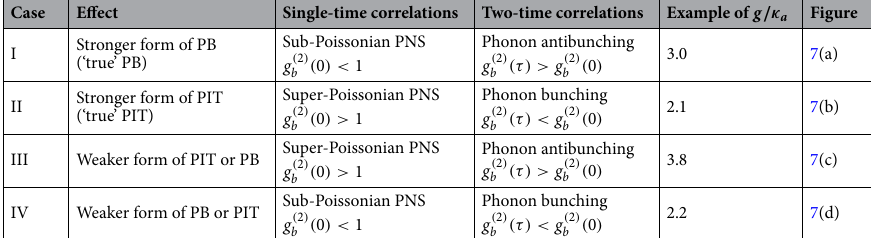
Table 2. Different single- and two-time phonon-number correlation effects induced in the QD mode, which can be observed for different values of the qubit-SMR coupling strength g with respect to the SMR decay rate κ a , e.g., by setting the other parameters to be the same as in Eq. (30). Here, PNS stands specifically for the phonon-number statistics of the mode b . Note that we also found examples of Cases I, II, and IV for the modes a and c using the same system parameters as for the mode b .